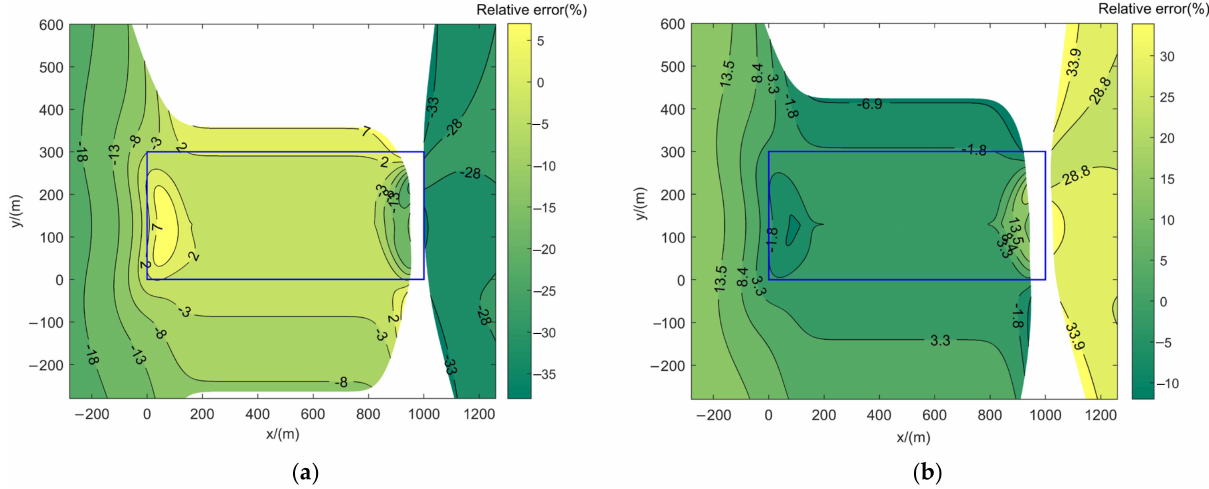
Figure 22. Relative errors of different values of r . ( a ) r is 112 m; ( b ) r is 208